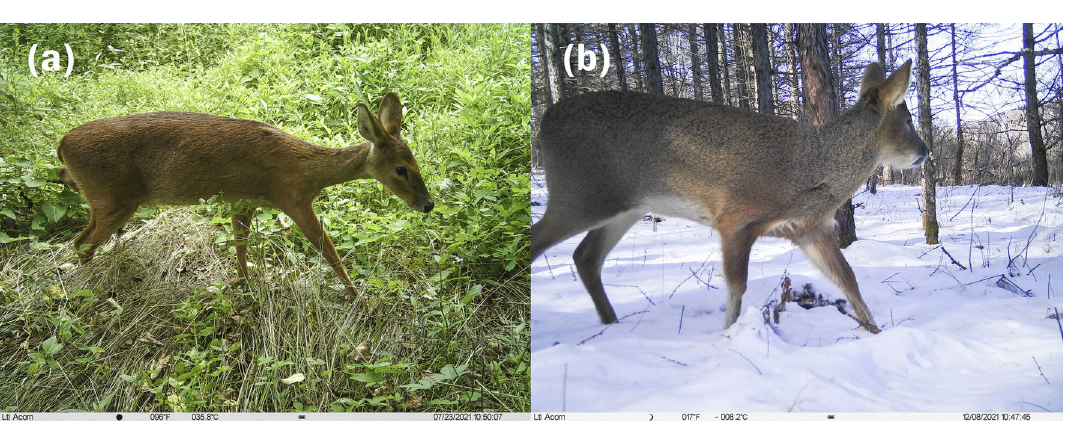
Figure 3. Photos of water deer captured by the infrared camera. ( a ) Photo of female water deer captured in summer. ( b ) Photo of male water deer captured in